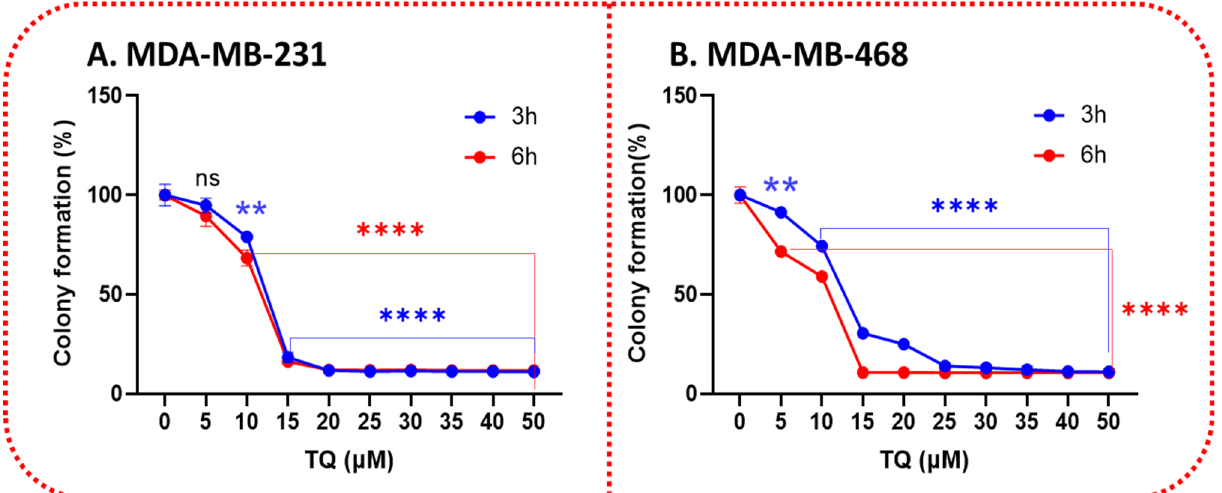
Figure 4. TQ treatment diminishes the clonogenic potential of TNBC cells. TQ’s colony formation effects over a prolonged period in MDA-MB-231 ( A ) and MDA-MB-468 ( B ) cells were shown by performing a colony formation assay. The TNBC cell lines were allowed to grow for seven days after treatment with 0–50 µM TQ for 3 and 6 h. Graphs were generated showing the relative colony formation ability of TNBC cells treated with TQ compared with controls. All error bars represent the standard error of the mean ( n = 6). ** p < 0.01, **** p < 0.0001; ns, nonsignificant.